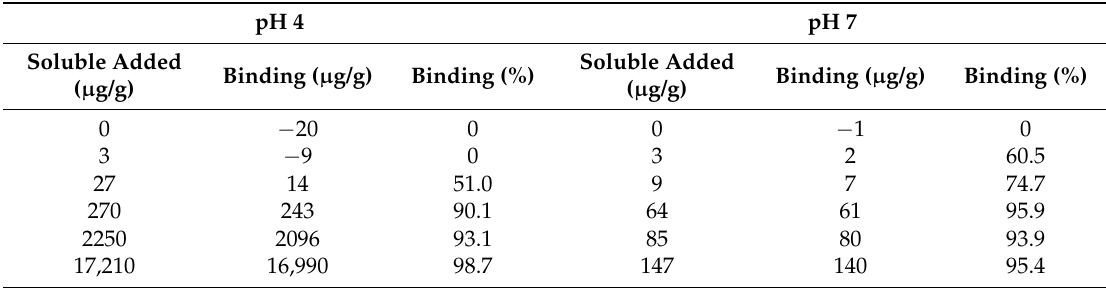
Table 4. Al binding to biochar at pH 4 and pH 7.